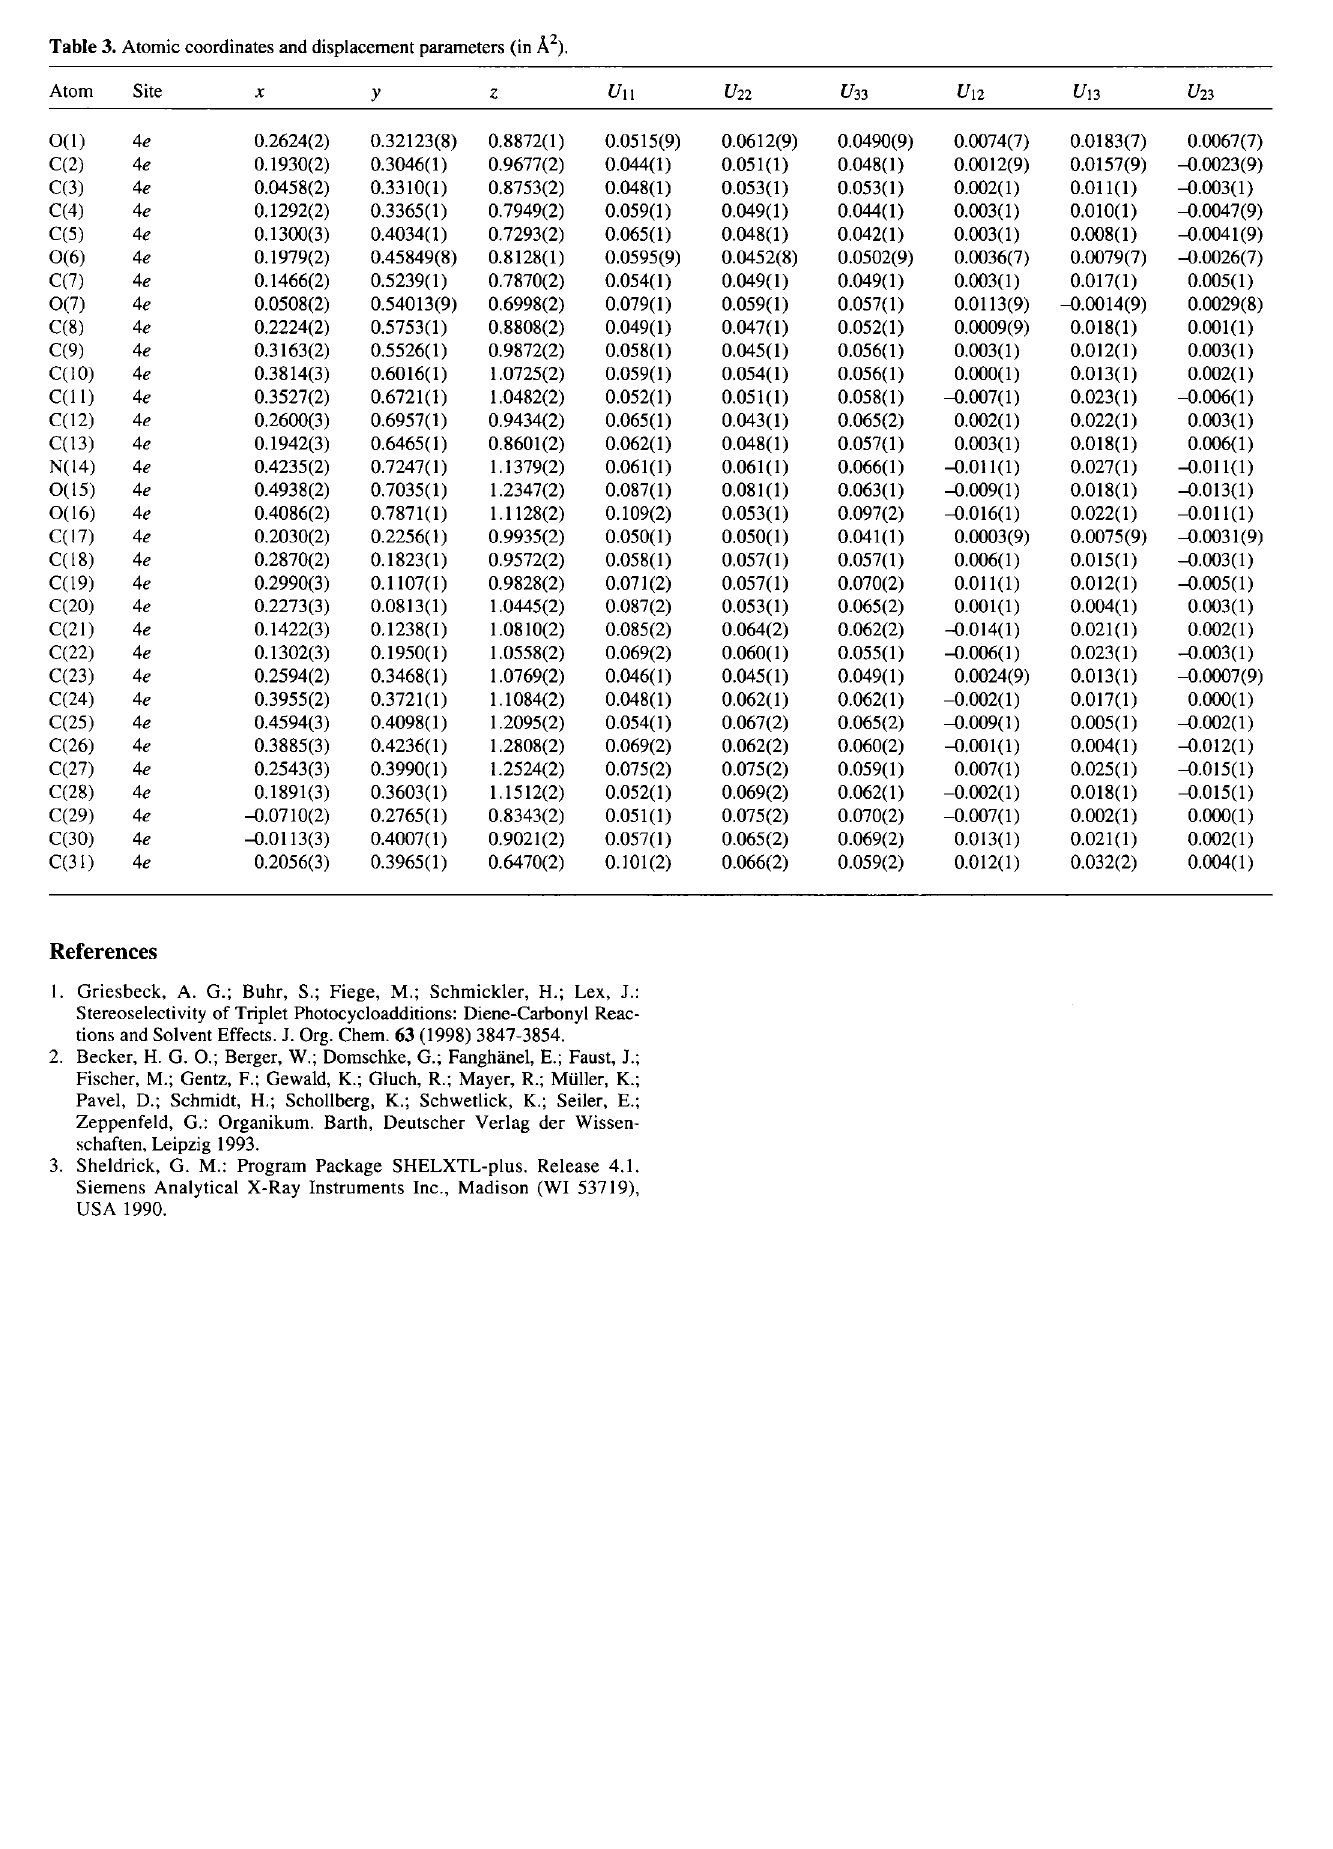
Table 3. Atomic coordinates and displacement parameters (in Ä 2